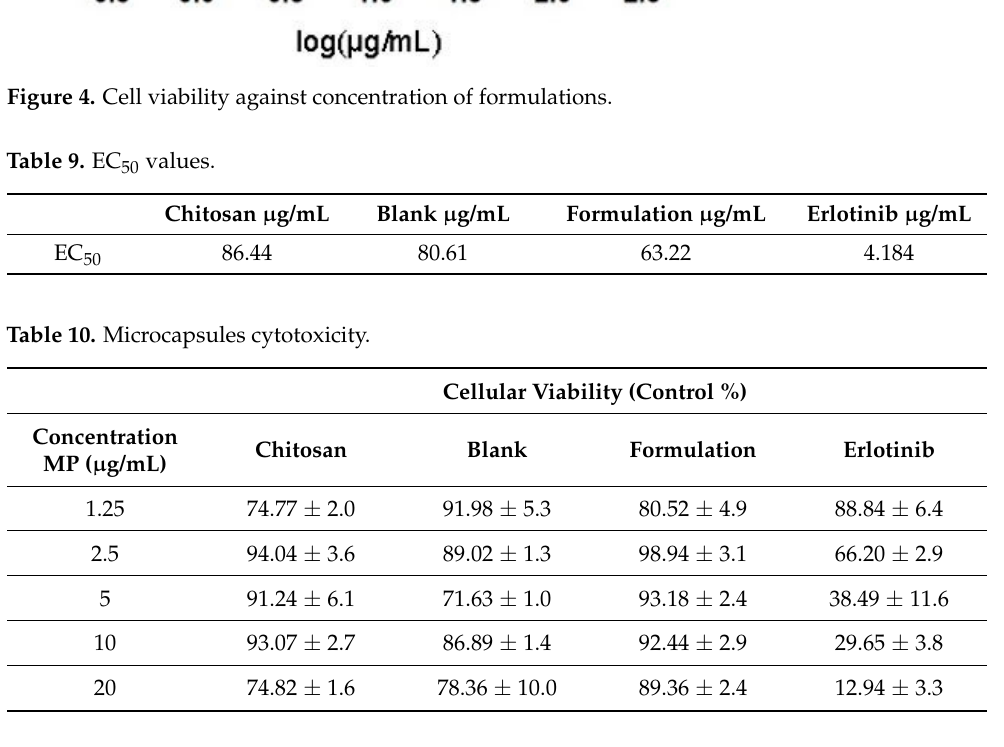
Table 10. Microcapsules cytotoxicity.